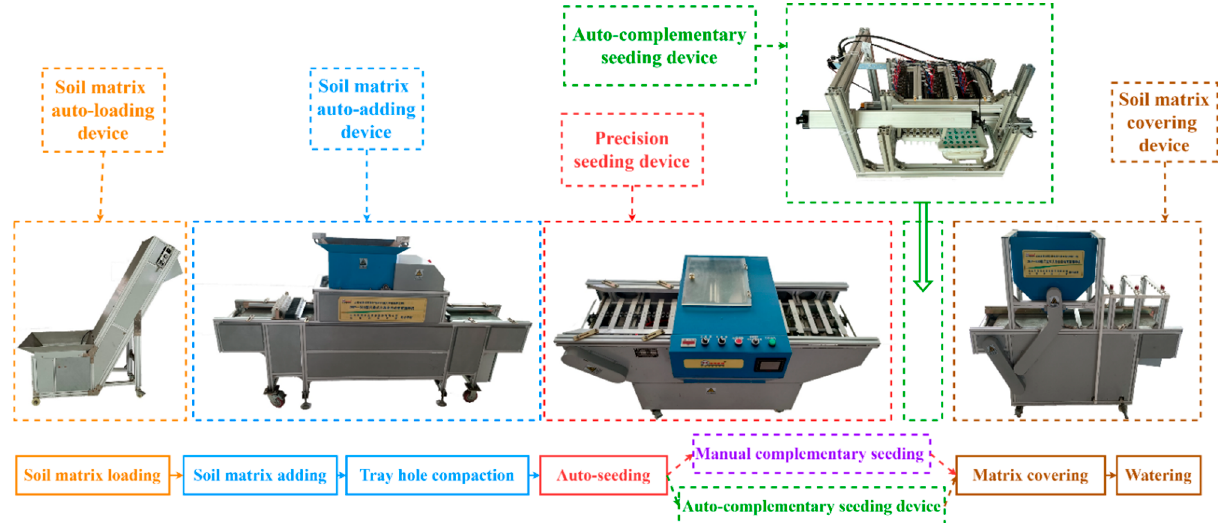
Figure 1. Tray-type green onion seedling machine.